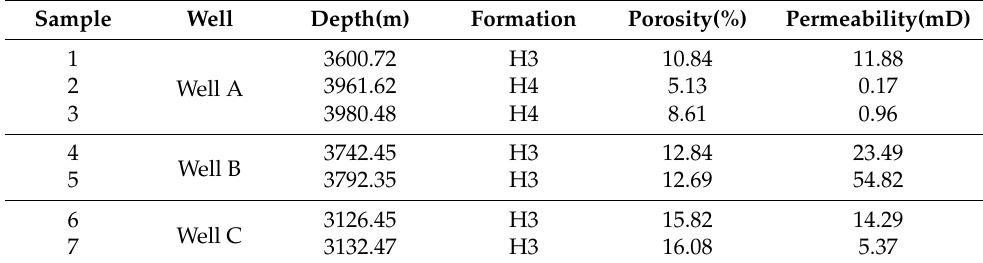
Table 1. Physical properties of seven core samples in Xihu